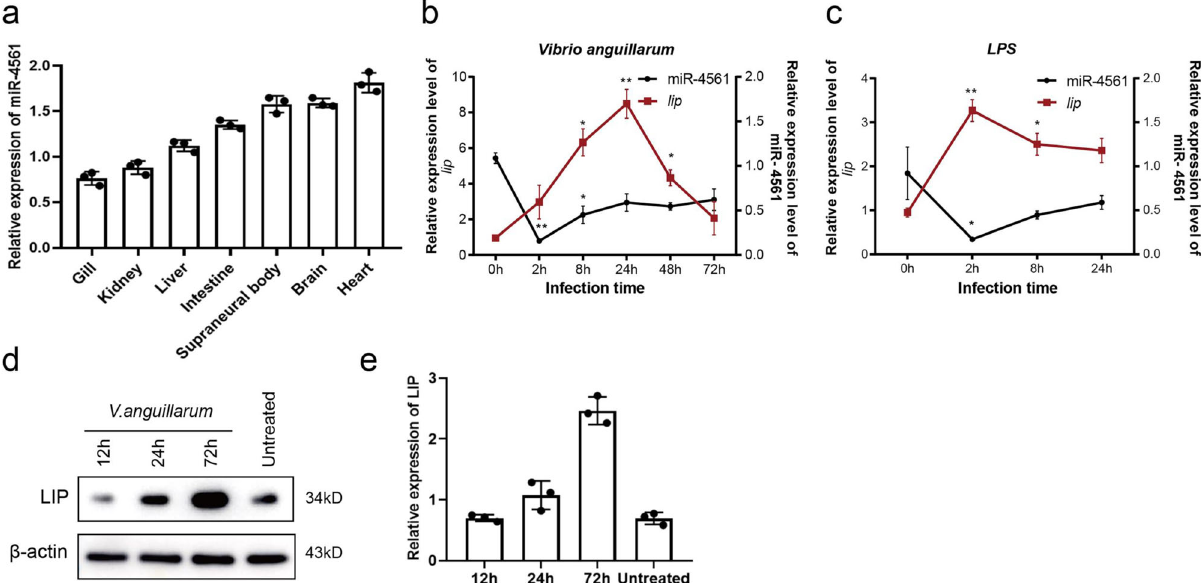
Fig. 3 miR-4561 expression is down-regulated following bacterial infection. a Relative expression of miR-4561 in lamprey tissues, as detected by qRT- PCR. b , c Time-course expression patterns of LIP and miR-4561 in lampreys infected with either V. anguillarum or LPS. d Time-course expression pattern of